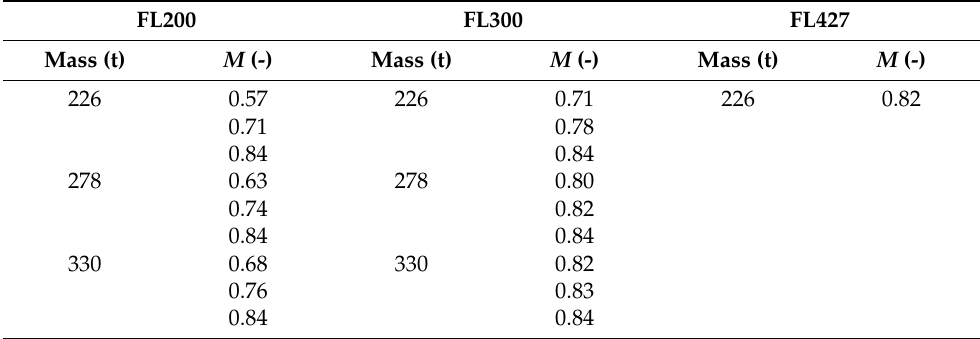
Table A3. Realistic flight operation conditions for B772LR at FL200, FL300, and FL427.